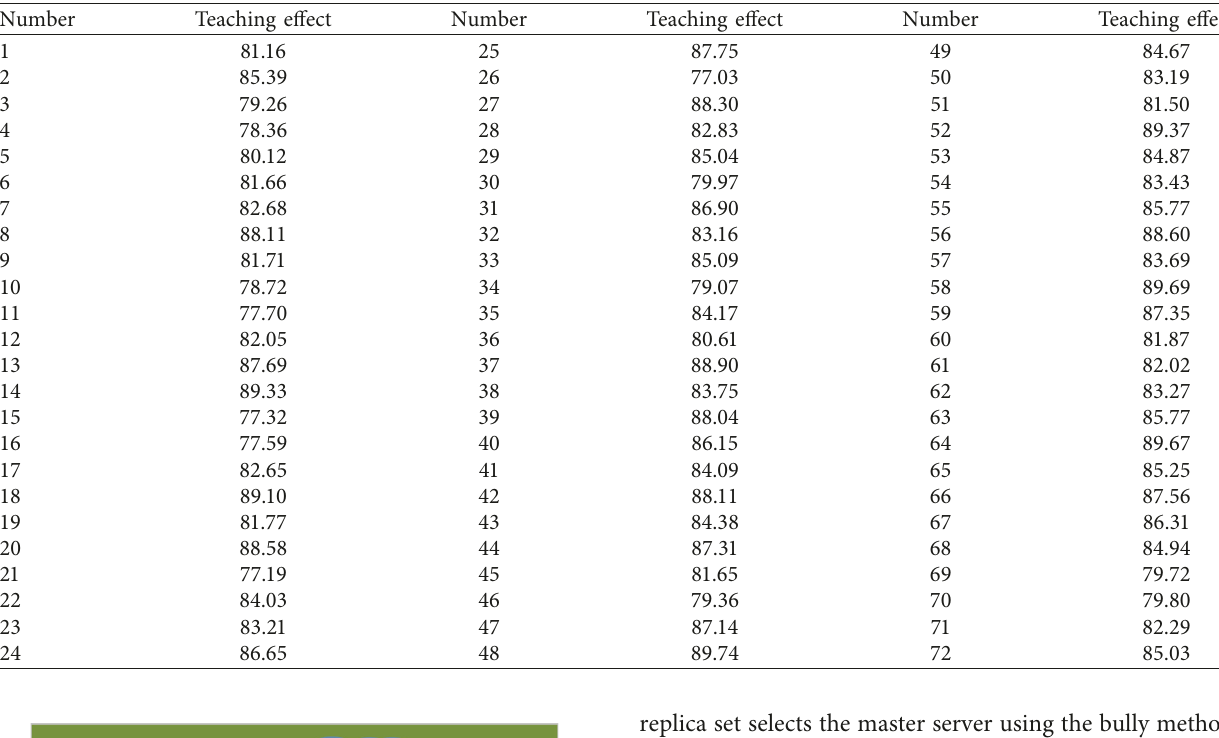
Table 1: Chinese teaching effect of international Chinese education expert system based on artificial intelligence and machine learning algorithm.